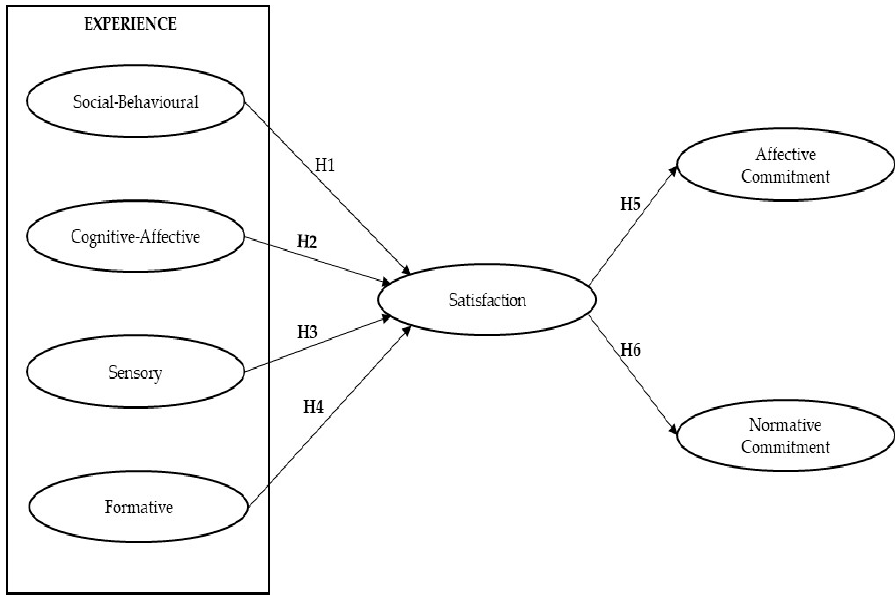
Figure 2. Conceptual model and hypotheses.